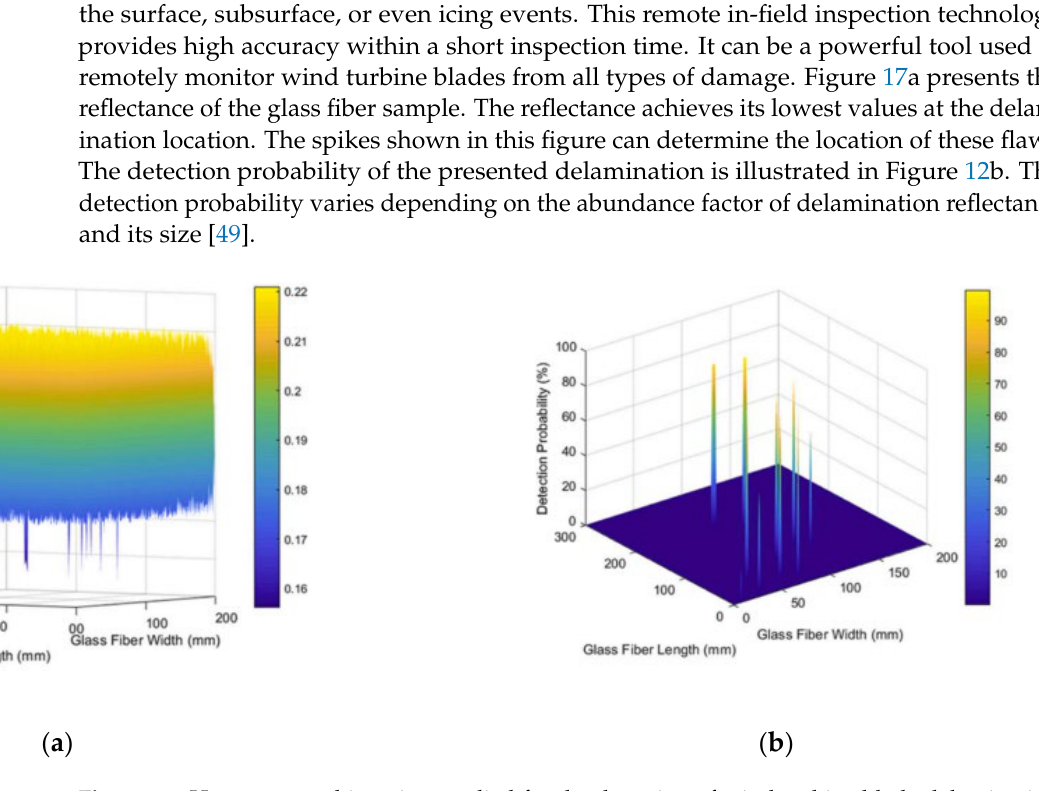
Figure 17. Hyper-spectral imaging applied for the detection of wind turbine blade delamination. ( a ) the reflectance of the glass fiber sample, ( b ) detection probability [49].